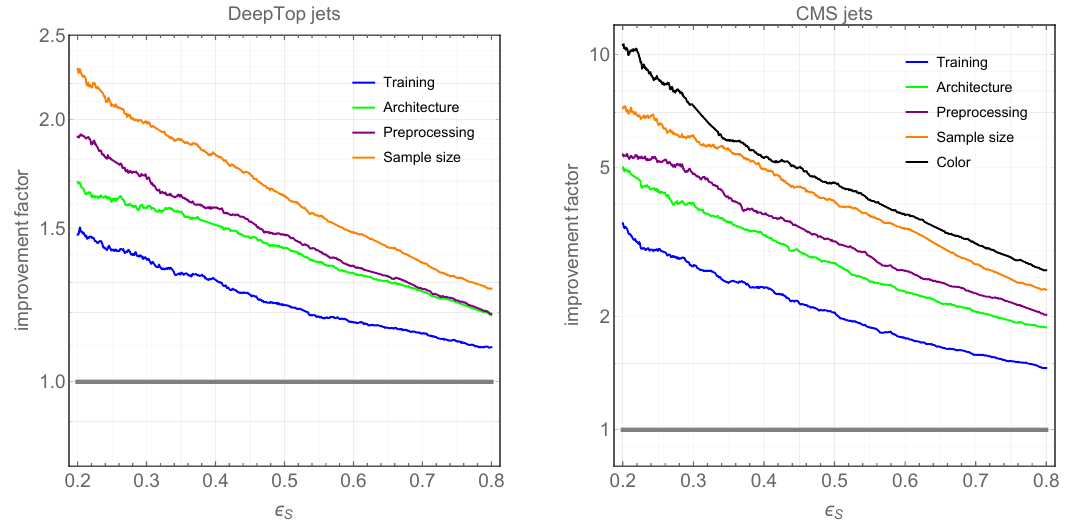
Figure 6 . Ratio of the ROC curves in (cid:12)gures 4{5 over the minimal DeepTop tagger ROC curve, providing another view of the cumulative